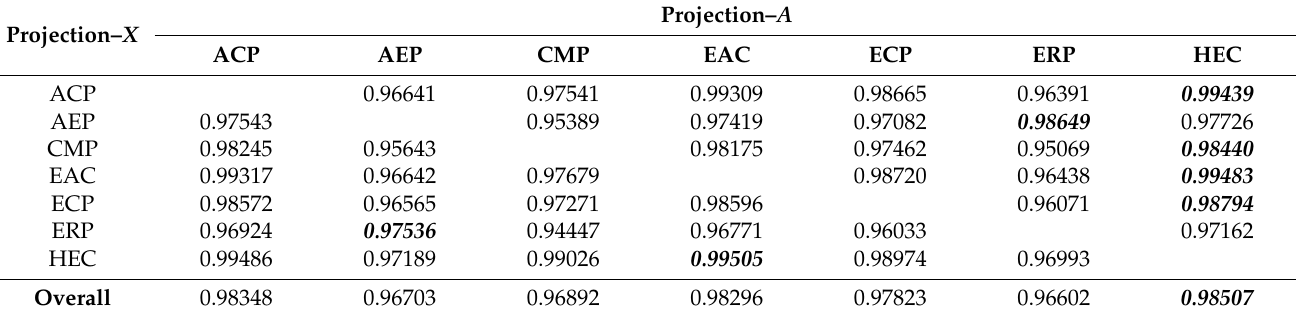
Table 3. Comparison using VIF (Average values at 2K, 4K, and 6K).